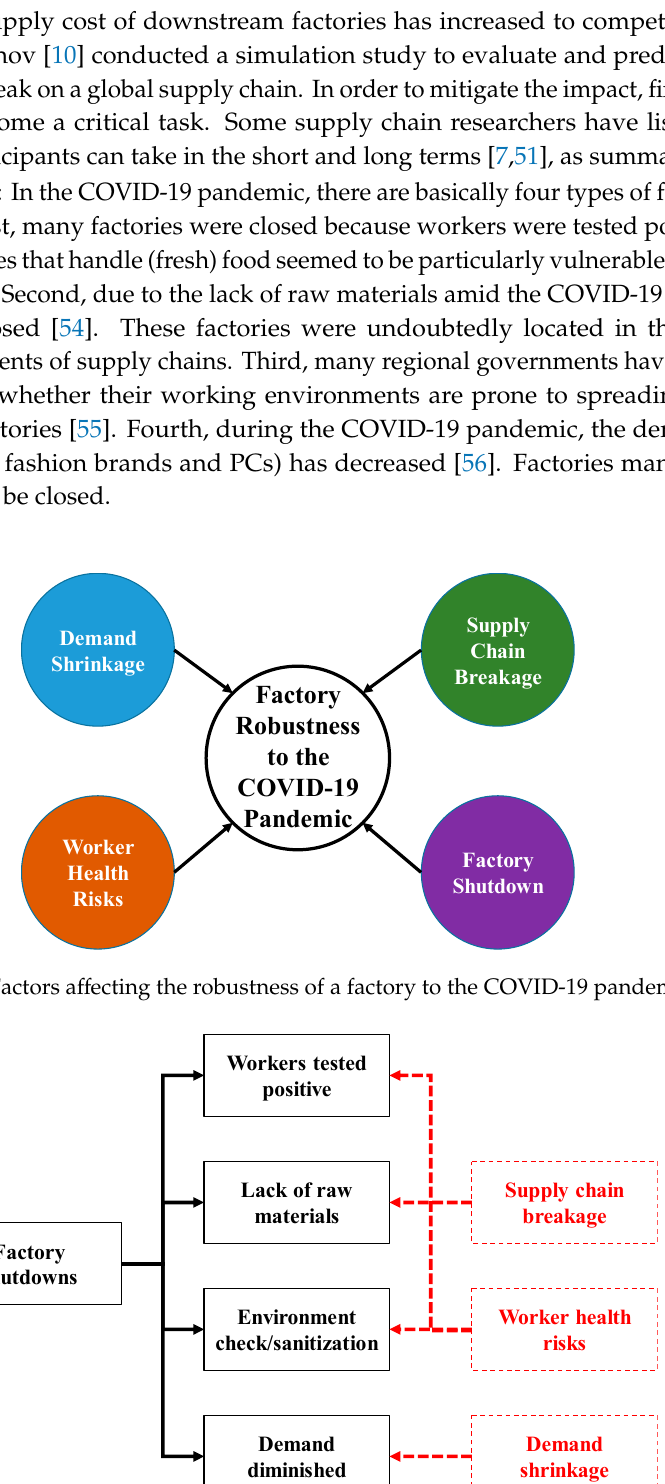
Figure 3. The main parts of the proposed methodology. The steps for implementing the proposed methodology are as follows: Step 1. (Each expert) Evaluate the relative priorities of critical factors using FGM. Step 2. If the evaluation results are consistent, go to Step 3; otherwise, return to Step 1. Step 3. If all experts reach an overall consensus, apply FI to aggregate experts’ evaluation results; otherwise, apply PCFI to aggregate experts’ evaluation results. Step 4. Apply FWI to assess the robustness of the target factory to the COVID-19 pandemic. Step 5. Apply FTOPSIS to compare the robustness of the target factory to that of another factory.